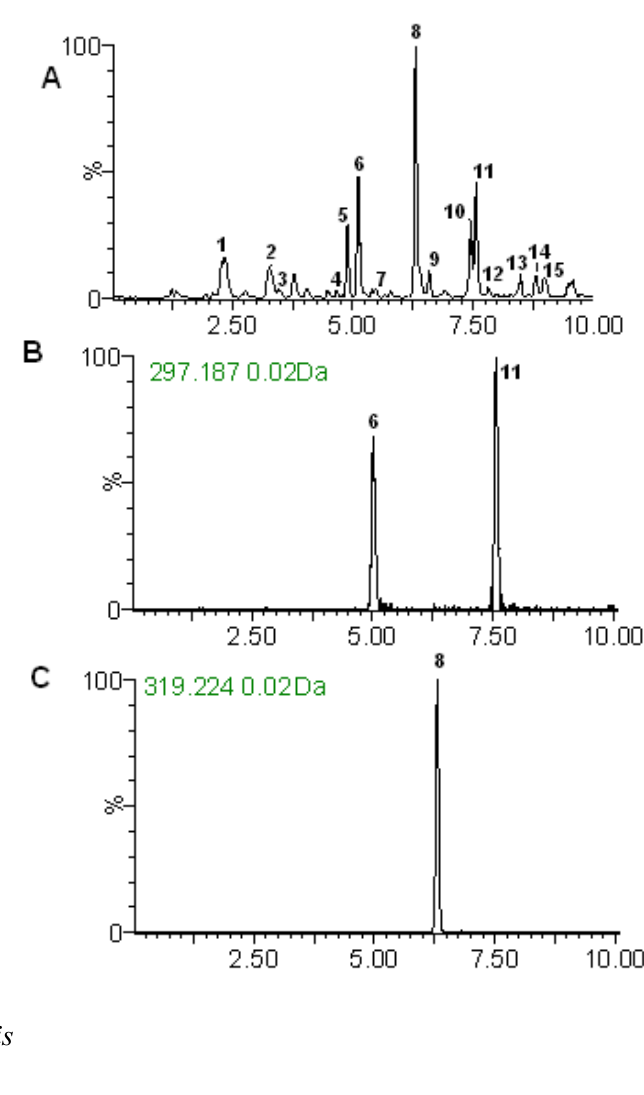
Figure 3. ( A ) Total ion chromatogram in positive ion mode of A. paniculata ; ( B ) The narrow widow extracted ion chromatograms (nwXICs) chromatograms for m/z 297.187 ( 6 and 11 ); ( C ) The nwXICs chromatograms for m/z 319.224 ( 8 ). The retention time is defined as the